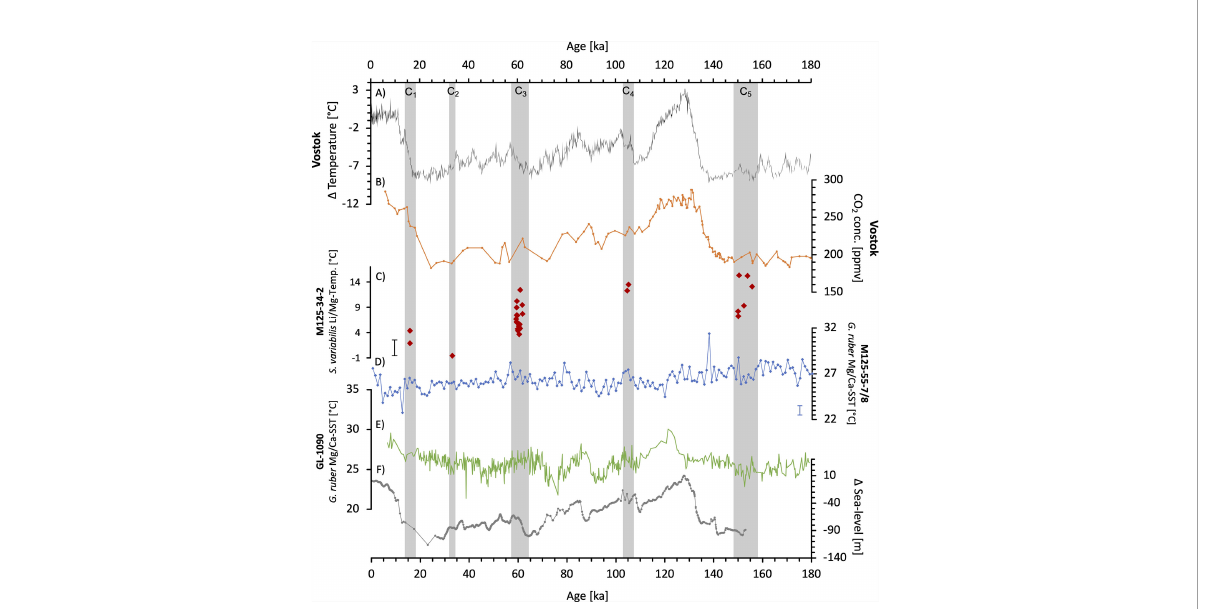
FIGURE 5 Evolution of enviromental parameters over the last 180 ka before present. (A) The temperature fl uctuations, averaged over the last 1,000 years, from the Vostok ice core (Petit et al., 1999). (B) CO2 concentration in ppmv reconstructed from the Vostok ice core (Petit et al., 1999). (C) Temperature reconstruction of the SAIW from sediment core M125-34-2, using the Li/Mg in the CWC S. variabilis (this study). With a 2SD of 1.55°C calculated from the JCp-1 measurements. (D) Temperature reconstruction of surface water from the southwestern tropical Atlantic (M125-55-7/8) based on the Mg/Ca of Globigerinoides ruber (G. ruber) (pink). The standard deviation is ±0.5°C (Hou et al., 2020). (E) Surface water temperatures of the subtropical western South Atlantic reconstructed from sediment core GL-1090 of the Mg/Ca of G. ruber (Santos et al., 2017). (F) Global sea level variations referenced to present-day sea level (Grant et al., 2012). The gray bars mark the intervals (C 1-5 ) of S.